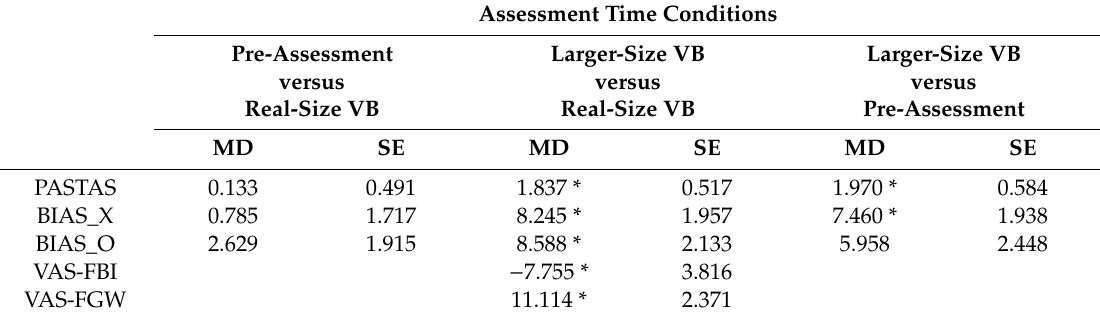
Table 3. Post-hoc analyses (pairwise comparison) at the di ff erent assessment times (pre-assessment, real-size virtual body and larger-size virtual